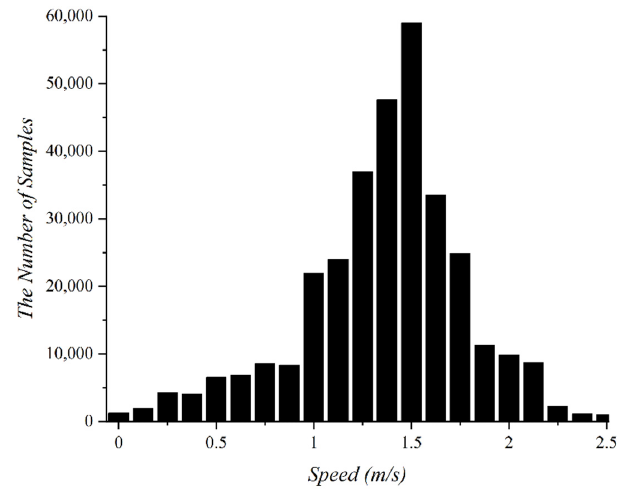
Figure 2. Distribution of the collected data according to moving speed.